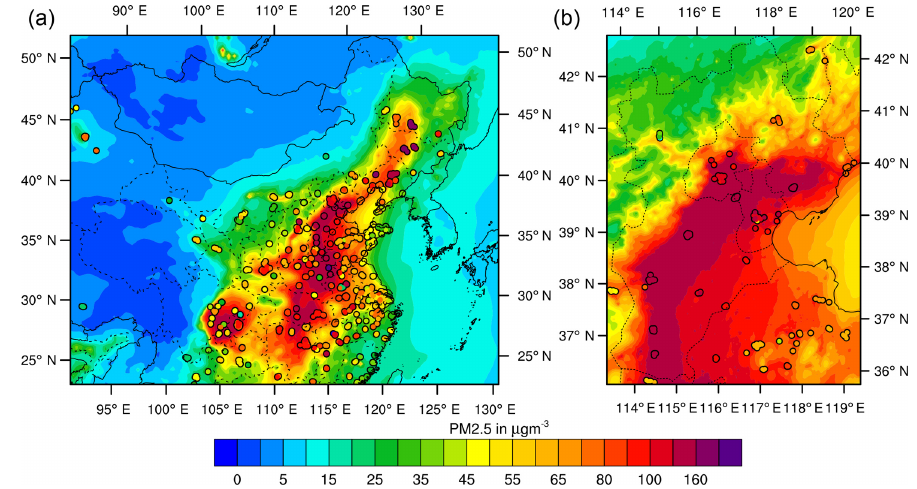
Figure 3. Average spatial distribution of PM 2 . 5 over the period 12–31 October 2014 for model domain 1 (China; a ) and domain 3 (North China Plain; b ) along with observations shown in